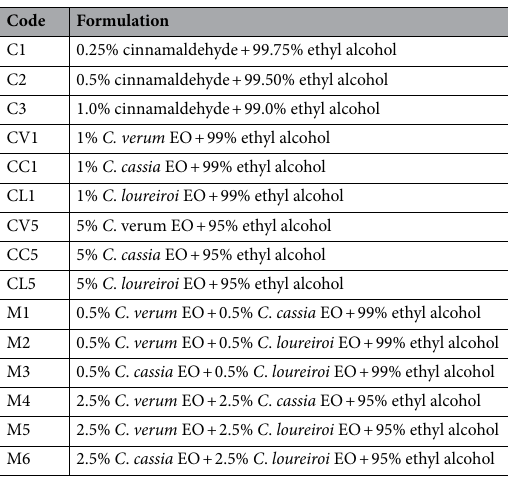
Table 6. Formulations of individual cinnamaldehyde, individual Cinnamomum spp. essential oils, and their combinations in this